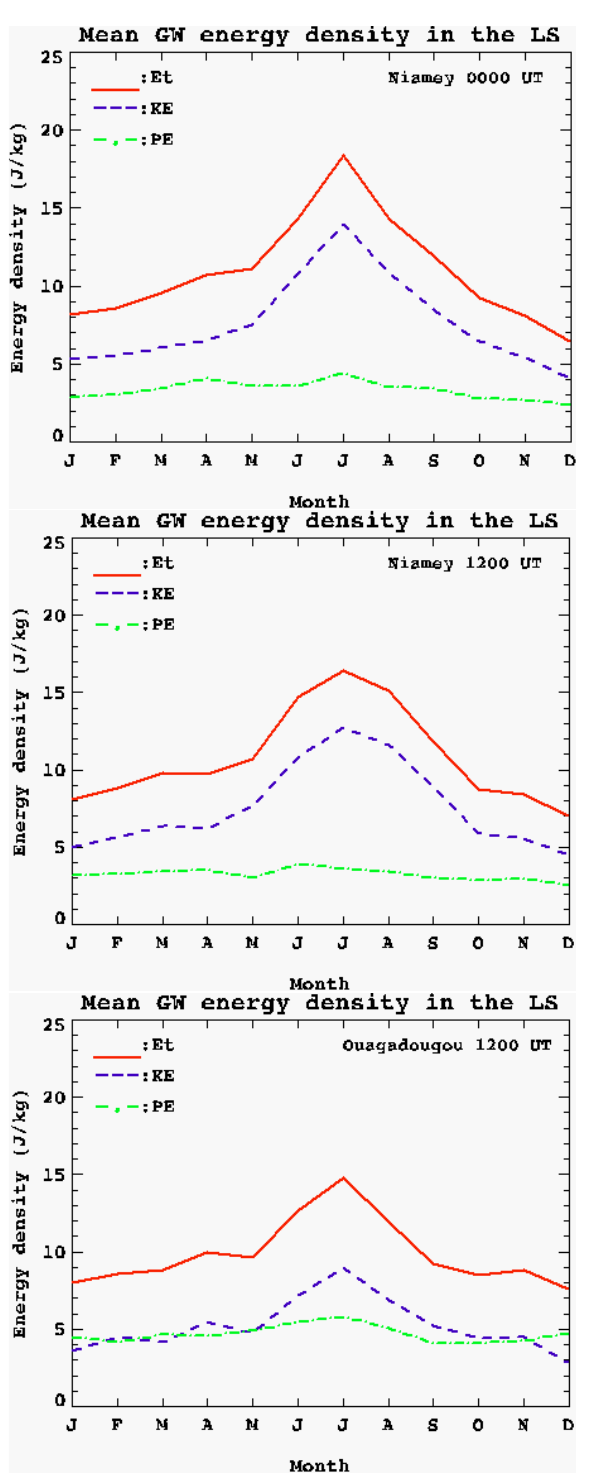
Fig. 5. Monthly mean total, potential and kinetic GW energy den- sity at height of 19–23km at (a) Niamey 00:00UT, (b) Niamey 12:00UT and (c) Ouagadougou 12:00UT. Monthly mean values are weighted by monthly number of selected profiles from January 2001 to December 2006.